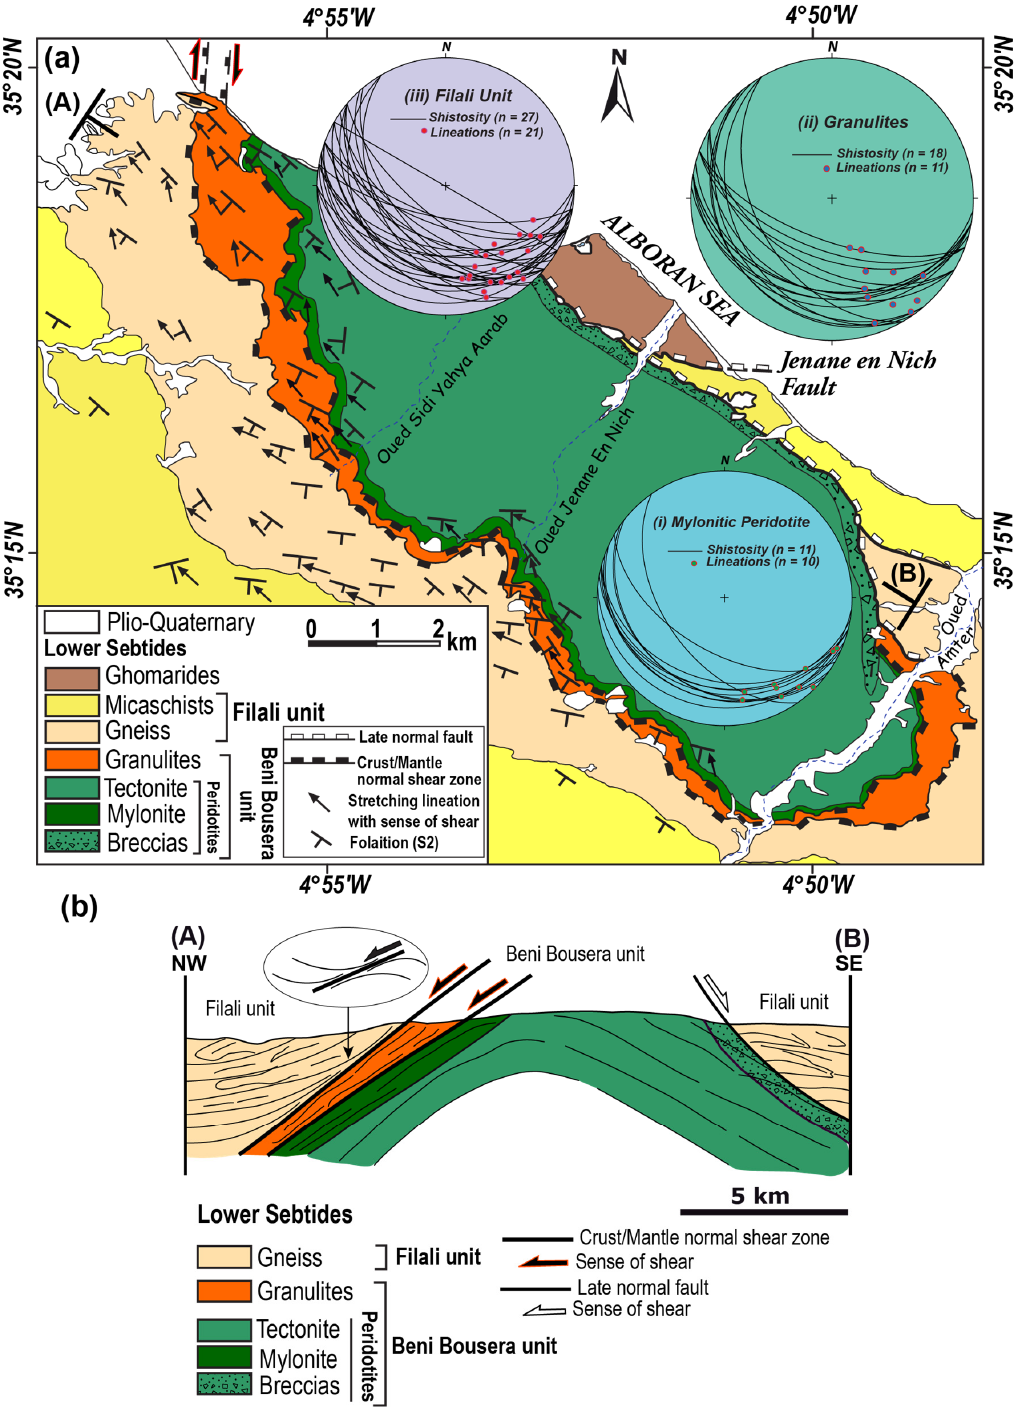
Figure 2. ( a ) Geologic and tectonic map of the studied area (the Beni Bousera peridotites and the overlying crustal rocks: granulite and Filali units) showing the main directions of the S2 foliation and stretching lineation. Foliation data are indicated by black symbols and lineation data are represented by black lines with arrows. The figure shows stereoplots, lower-hemisphere equal-area projections of structural data, of the poles of the plane foliation and lineation in the peridotites (i), in the granulite (ii), and in the Filali unit (iii), modified after Afiri et al. [33], Reuber et al. [40] and El Bakili et al. [54]. ( b ) NW–SE cross-section showing that the contact between the Beni Bousera peridotites and crustal rocks consists of a lithospheric scale extensional shear zone.